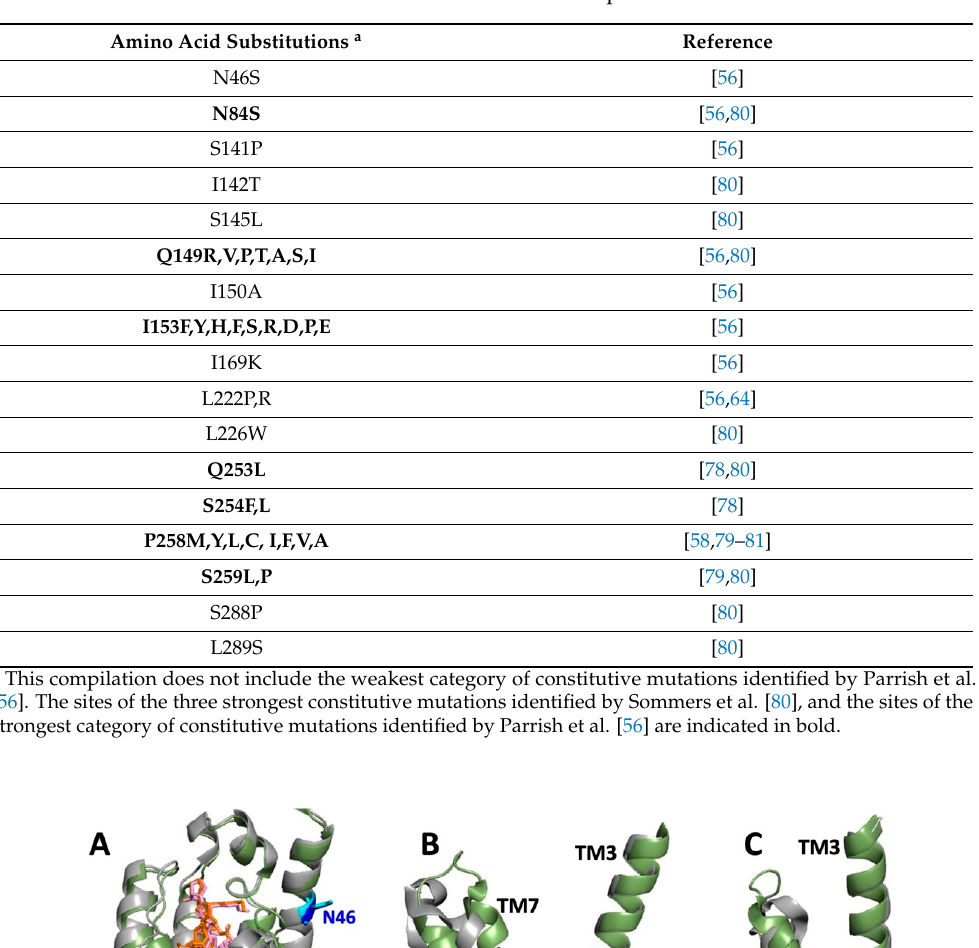
Table 1. Mutations that result in constitutive activation of Ste2p.